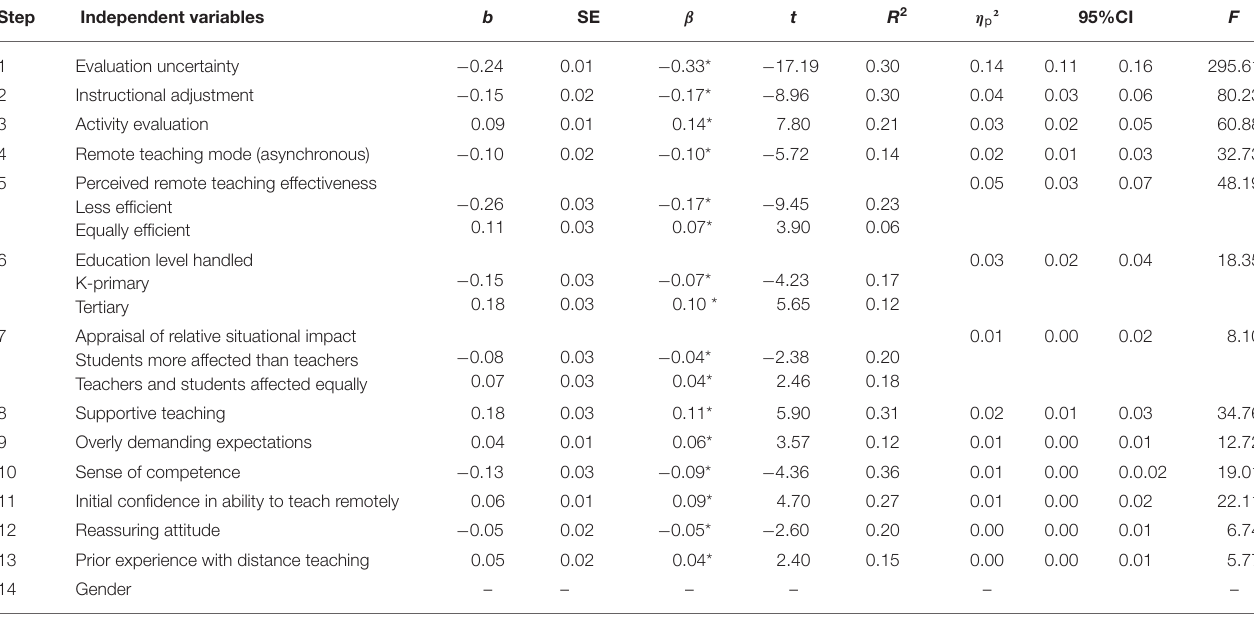
TABLE 5 | General linear model with ANCOVA (forward selection stepwise regression) for variables predicting teachers’ perception of student coping with remote